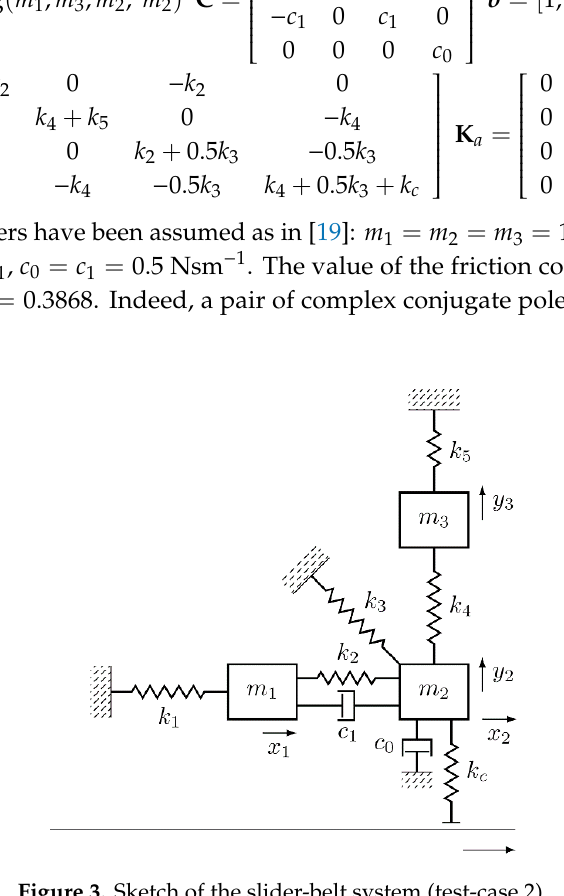
Figure 3. Sketch of the slider-belt system (test-case 2).